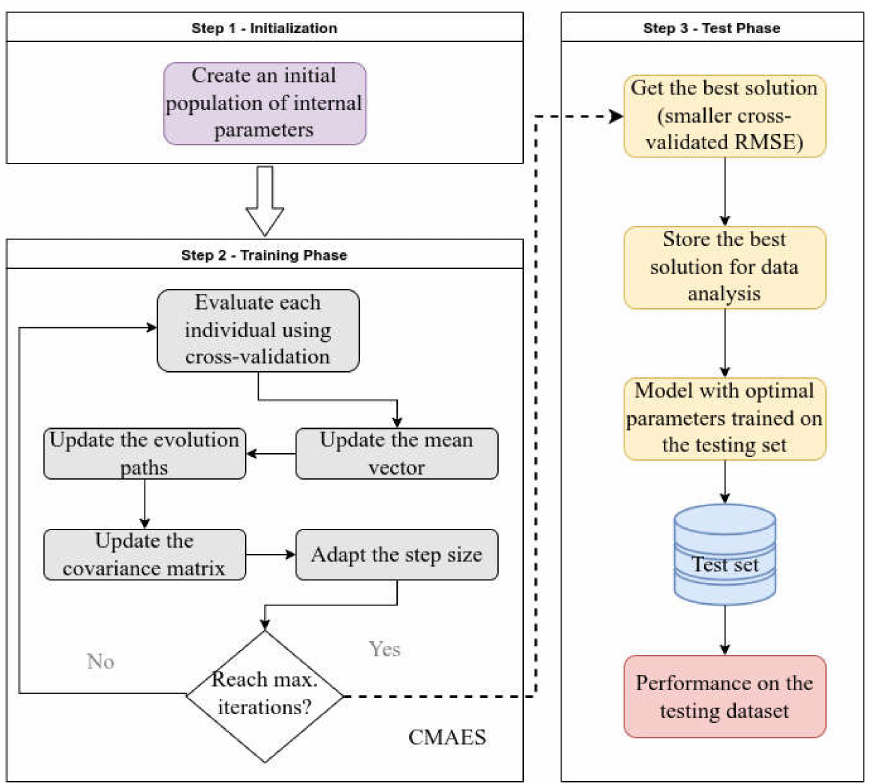
Figure 3. Framework used in this paper showing the combination of the CMAES evolutionary algorithm and the machine learning